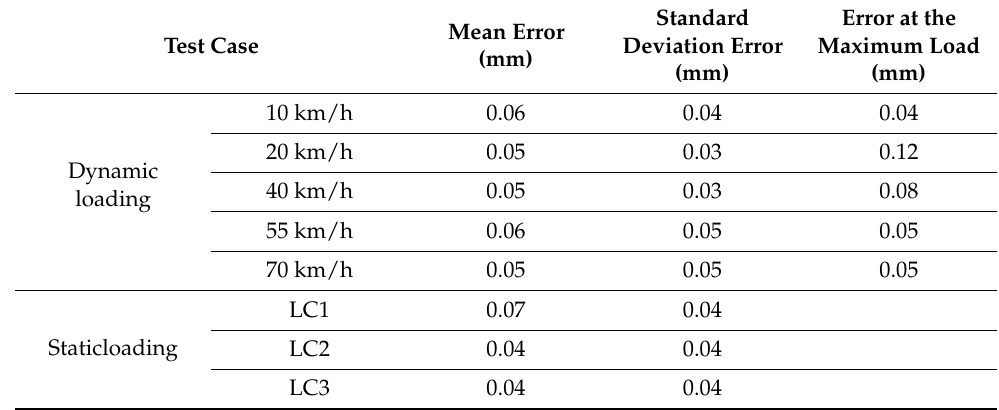
Figure 12. Bridge vibration motion comparison. Table 2. Mean errors, standard deviation errors, and maximum errors for measured displacement signals during the field tests.